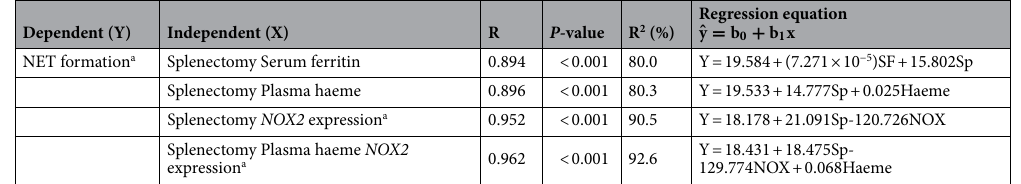
Table 1. A multivariate analysis of NET formation and clinical parameters. NOX; NOX2 expression, SF; serum ferritin, and Sp; splenectomy. The splenectomy was scoring by 1 for normal subjects (non-splenectomised), 2 for non-splenectomised β-thalassaemia/HbE patients and 3 for splenectomised β-thalassaemia/HbE patients. a NET formation and NOX2 expression were analyzed from spontaneously untreated neutrophils in culture media at 90 min 37ºC,